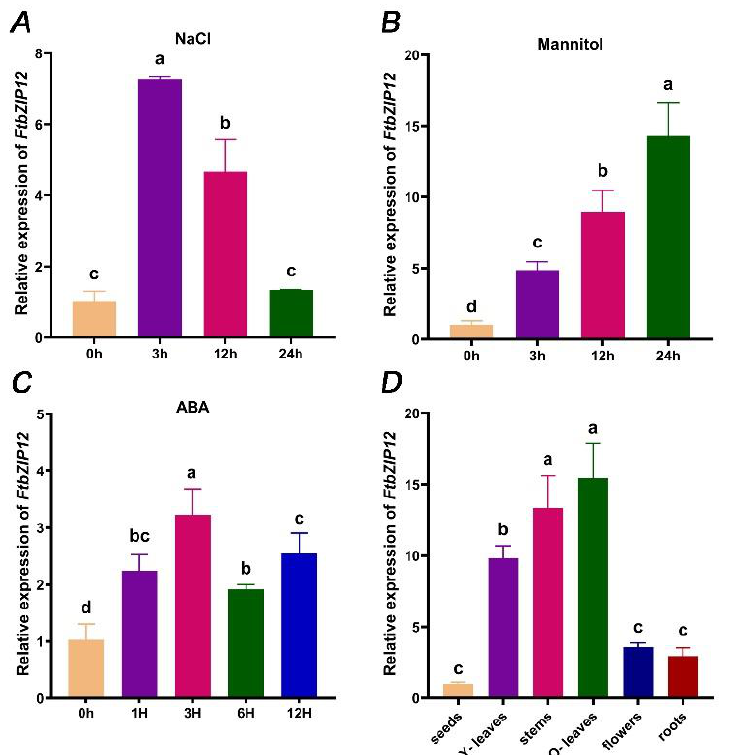
Figure 2. Expression pattern of FtbZIP12 . ( A ) Expression analysis of FtbZIP12 in response to 300 mM NaCl, ( B ) 375 mM mannitol, and ( C ) 100 µ M ABA while taking the material treated at 0 h as the control. ( D ) The expression levels of FtbZIP12 in roots, stems, flowers, seeds, and leaves at different developmental stages while taking the seed as the control. Values are expressed as means ± SD ( p < 0.05); each data value is from three replicate experiments.